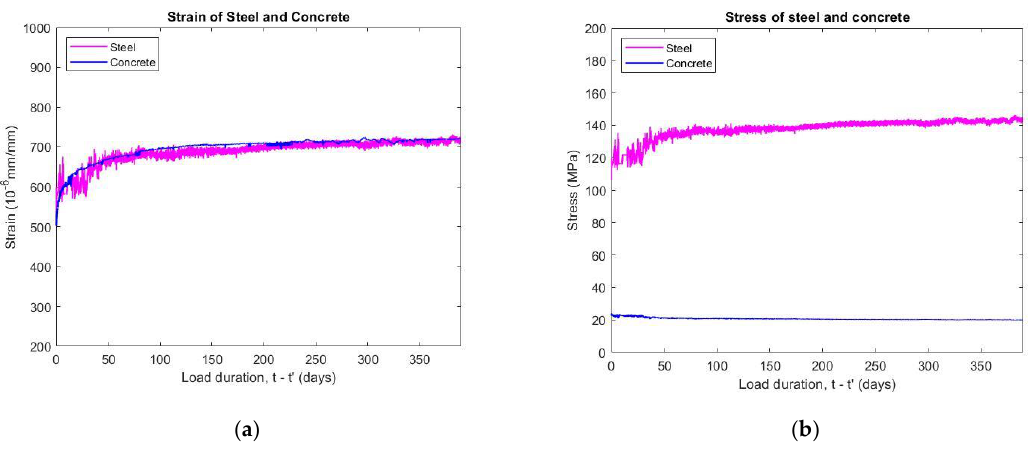
Figure 12. Strains and stresses of steel tube and concrete core: ( a ) vertical strains, ( b ) vertical stresses.